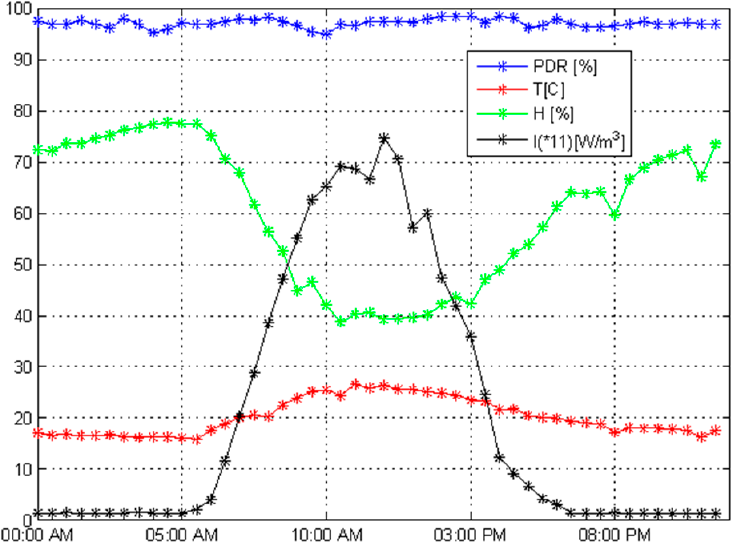
Figure 4. Behavior of FSO link vs weather factors during March 2015 (spring season).